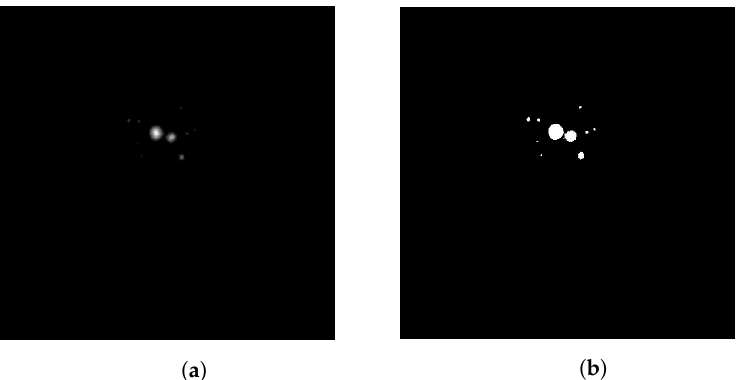
Figure 3. Distance transform. ( a ) Frame of the output image resulting from the application of the distance transform on the binary mask produced by the segmentation of the vessels. ( b ) The corresponding frame of vessels’ binary